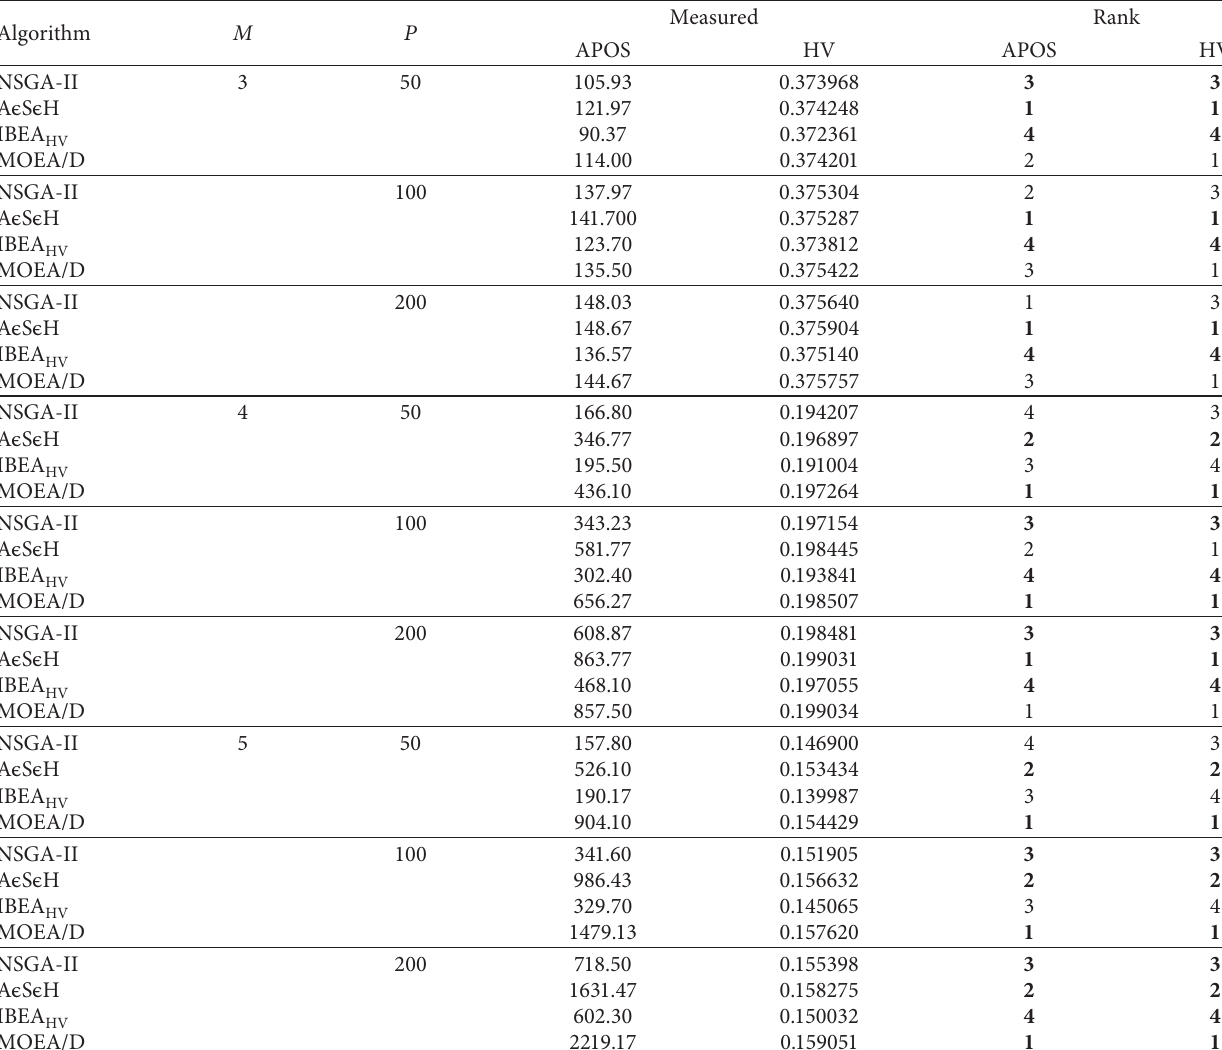
Table 3: Algorithm comparison by accumulated PO solutions (APOS, feature) and hypervolume (HV, performance metric).